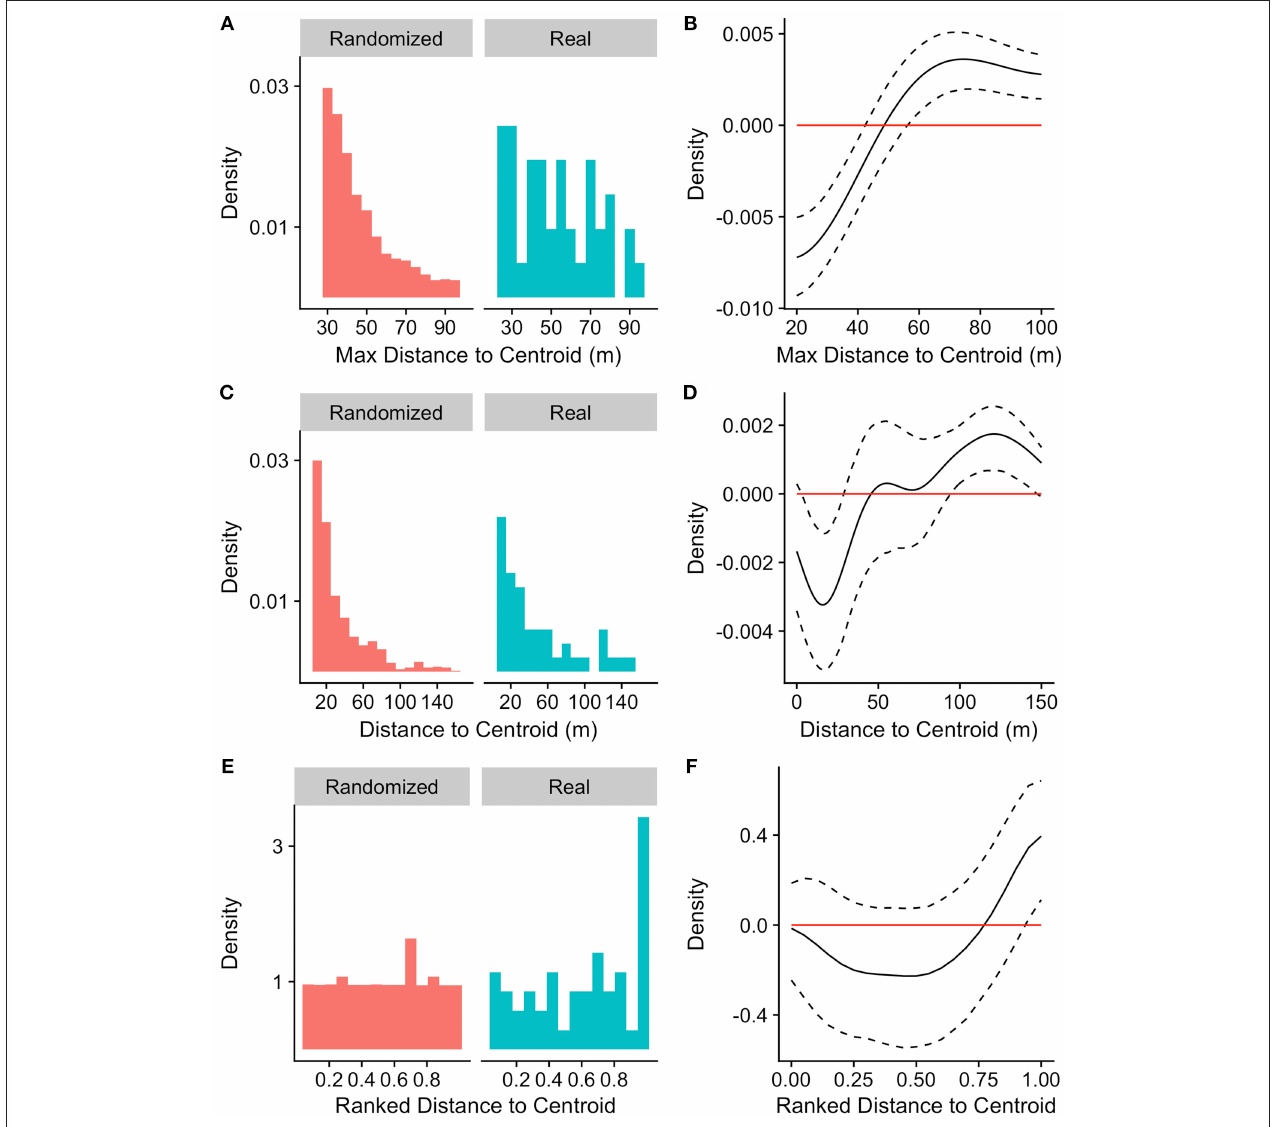
FIGURE 2 | Distributions of (A) maximum distance to centroid, (C) distances to centroid of callers, and (E) callers’ ranked distances from the centroid (1 = furthest) at the time of the first call in a bout for real and randomized datasets. (A) n real = 57 calls, n rand = 10,000 iterations of 57 randomly selected time points, (C,E) n real = 50 calls, n rand = 10,000 permutations of caller identity for 50 calls. (B,D,F) Represent differences between density functions for real minus randomized